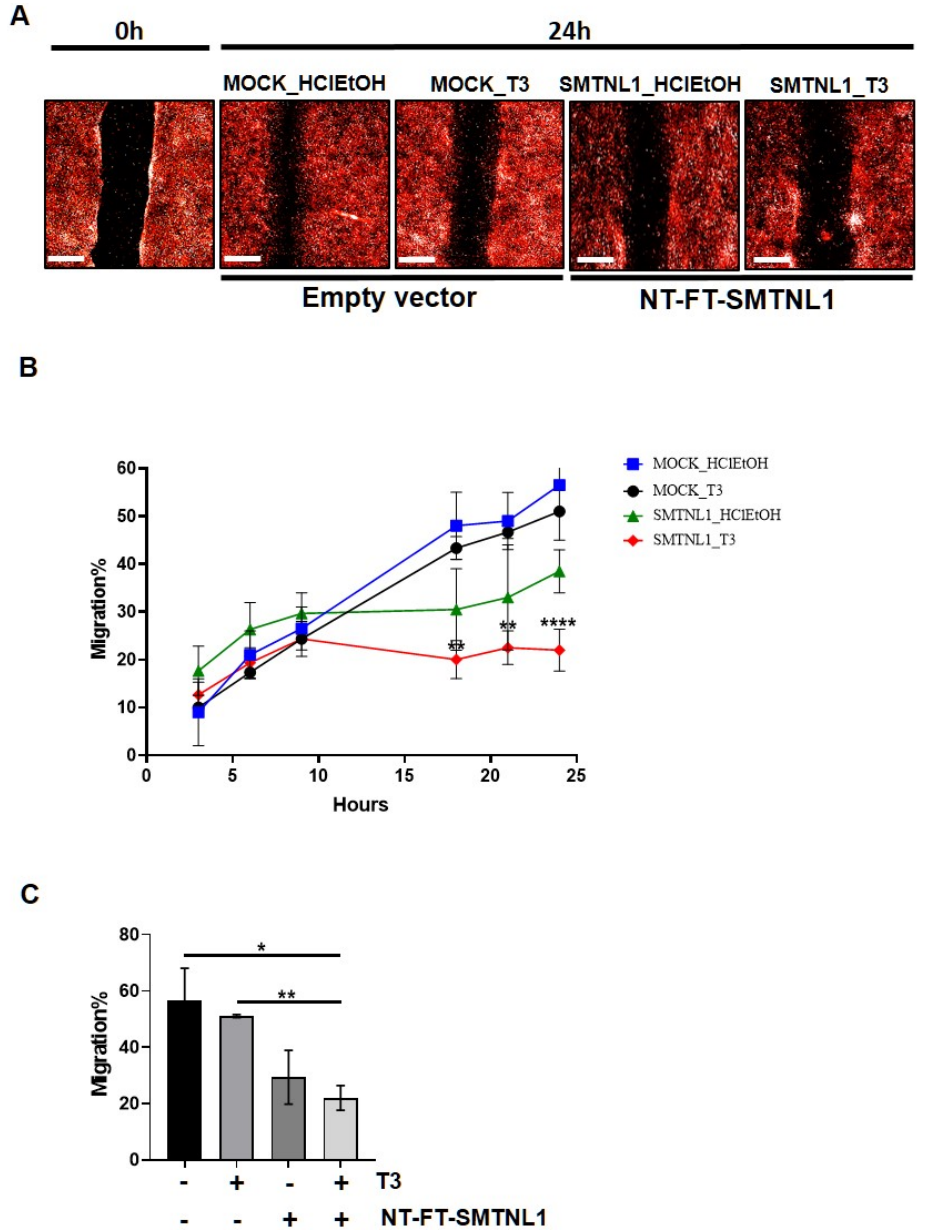
Figure 5. Scratch assay of T 3 -treated and SMTNL1 overexpressing myoblasts. Myoblasts were stained and transfected with empty vector or NT-FT-SMTNL1. After 48 h of culturing and a 5-h serum starvation, cells were scratched and were grown for additional 24 h in the presence of 10 nM T 3 . ( A ) Photos of scratch areas were taken with a 10× air objective at the indicated times. Scale bars: 500 µm. ( B ) 24-h kinetic curve of migrating C2C12 myoblasts. ( C ) Bar charts show covered scratch areas after 24 h. Values represent n = 3, mean ± SEM. Data were normalized to the empty vector-transfected control (MOCK). Differences between group means were determined using Two-way ANOVA ( B ) or One-way ANOVA ( C ) followed by Tukey’s post hoc test, p < 0.05 (*), p < 0.01 (**), p < 0.0001 (****).